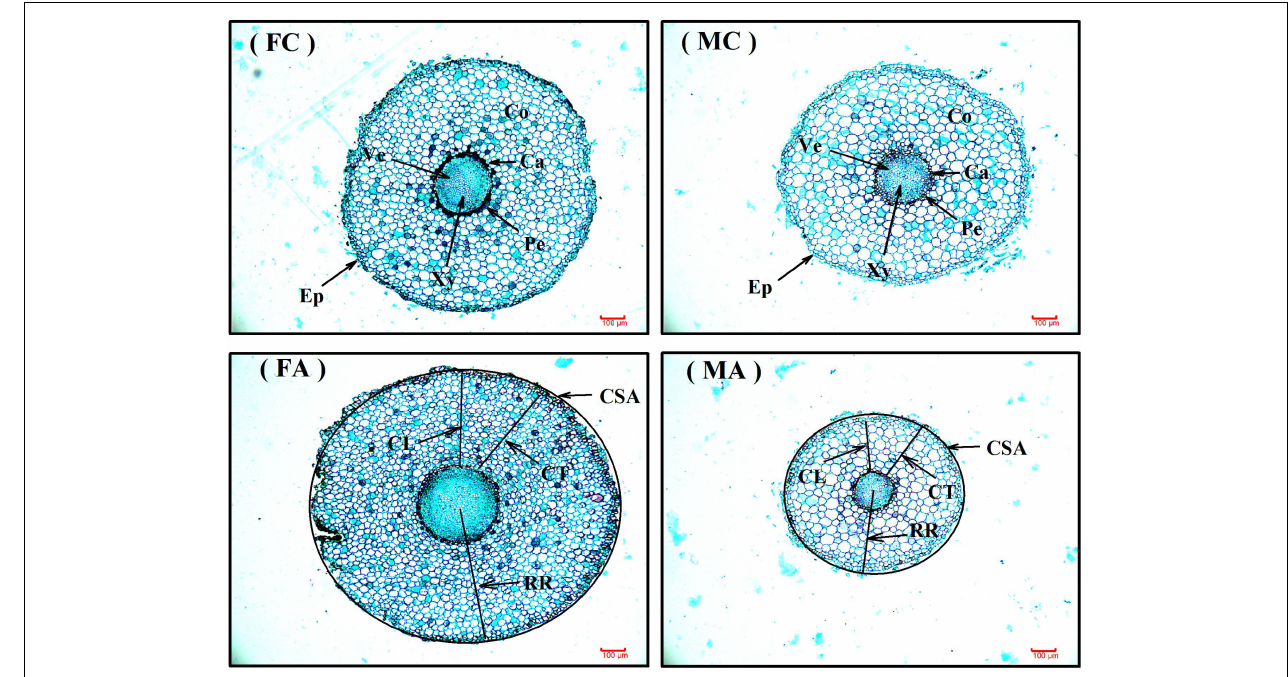
FIGURE 1 | The root anatomic traits of female and male Populus cathayana saplings under non-inoculated (control) and inoculated condition. The bars shown are 100 µ m. FC, control females; MC, control males; FA, females under inoculated condition; MA, males under inoculated condition; Ca, cambium; CL, cortical layer; Co, cortex; CSA, cross-section area; CT, cortical thickness; Ep, Epidermis; Pe, pericycle; RR, radius of root tips; Ve, vessel; Xy,